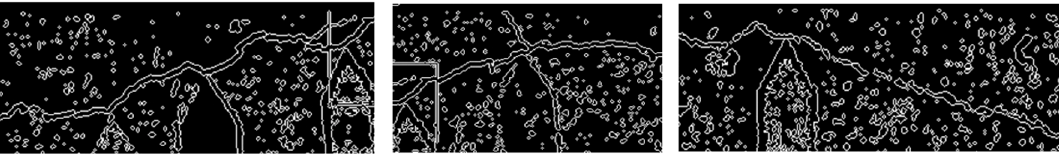
Table 6. Morphological planar marking measurements (spatial resolution of one pixel: 0.216 mm).